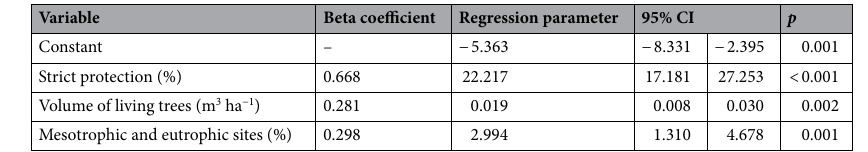
Table 3. Linear regression results for the density of standing deadwood with DBH ≥ 30